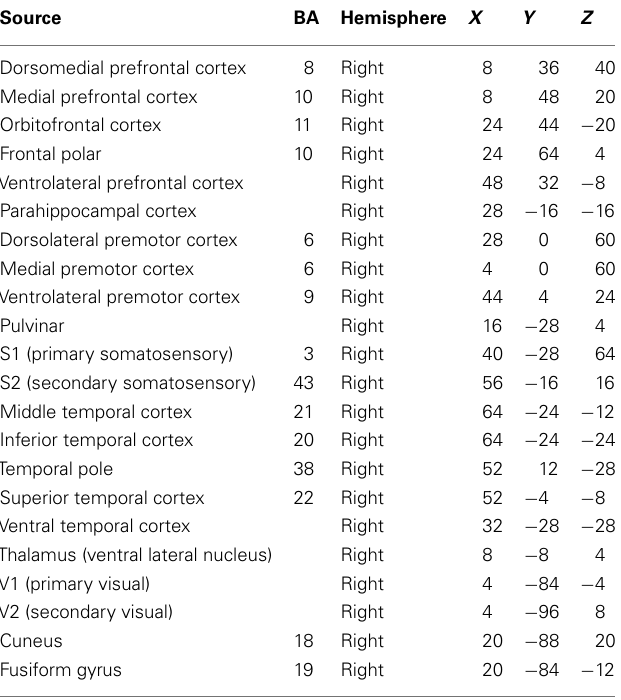
Table adapted from Diaconescu et al.